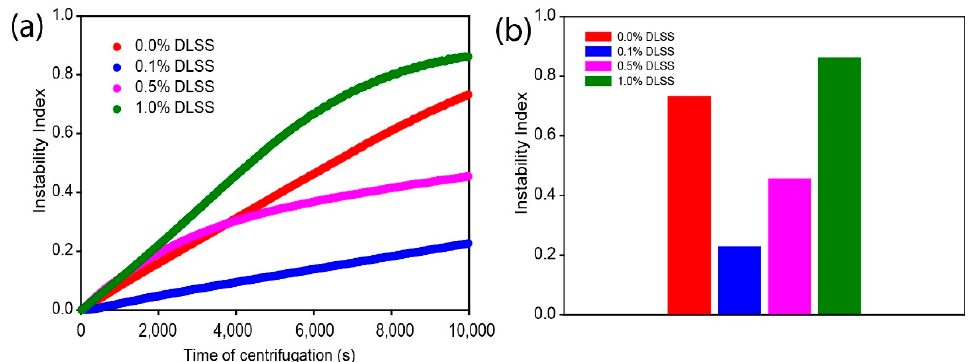
Figure 1. ( a ) Variation of instability index with the time of centrifugation for Al 2 O 3 ceramic slurries containing various amounts of DLSS (wt.%) and ( b ) comparison of instability index as a bar graph for Al 2 O 3 slurries.